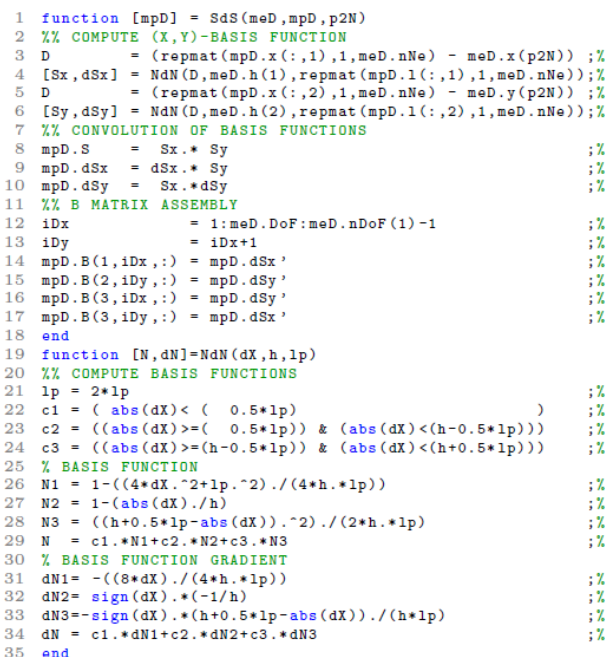
Figure 4. Code fragment 1 shows the vectorized solution to the cal- culation of the basis functions and their derivatives within SdS.m . Table B1 lists the variables